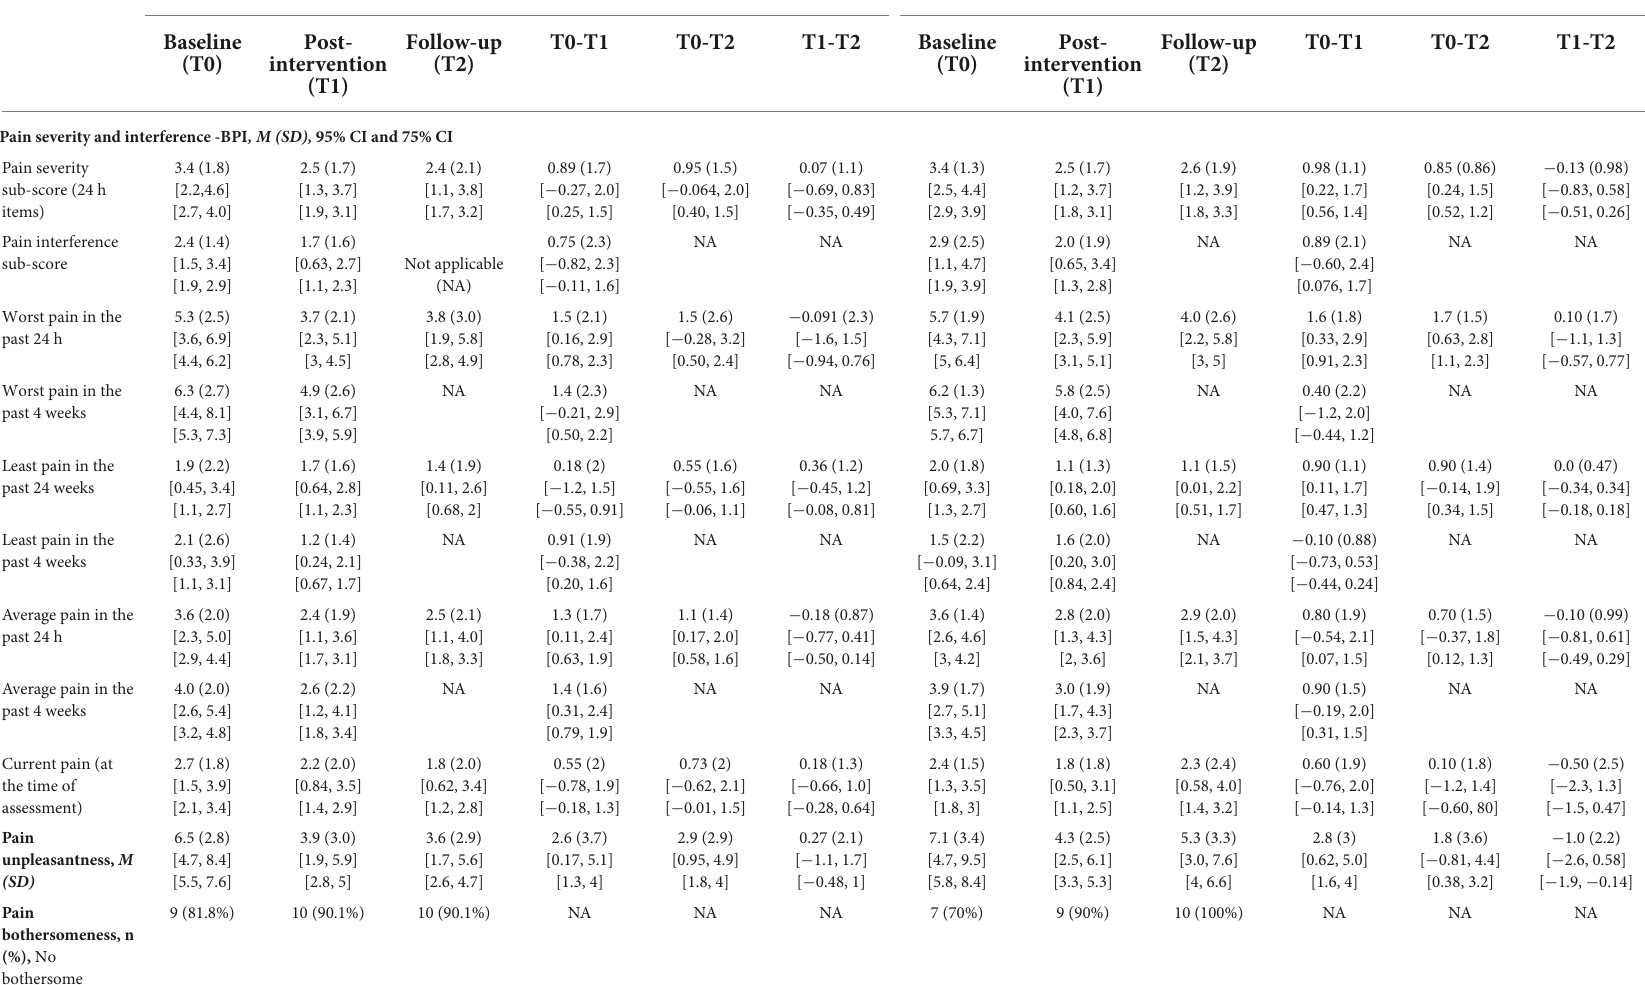
TABLE 4 Results of pain and function outcome measures . Domains and